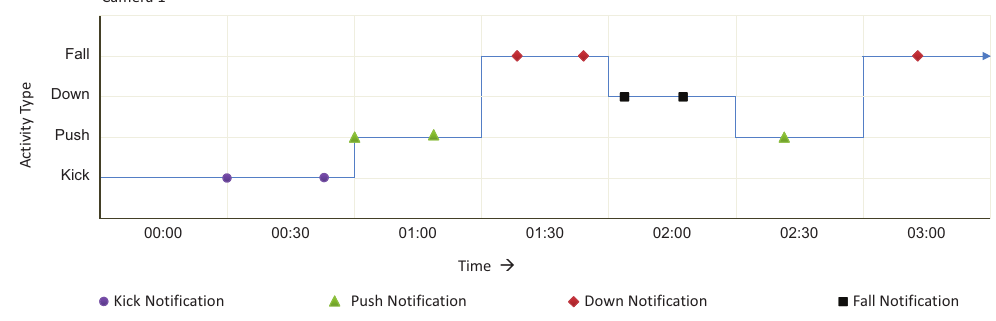
Figure 20. Camera 2 video stream monitor against the service Activity Recognition for three